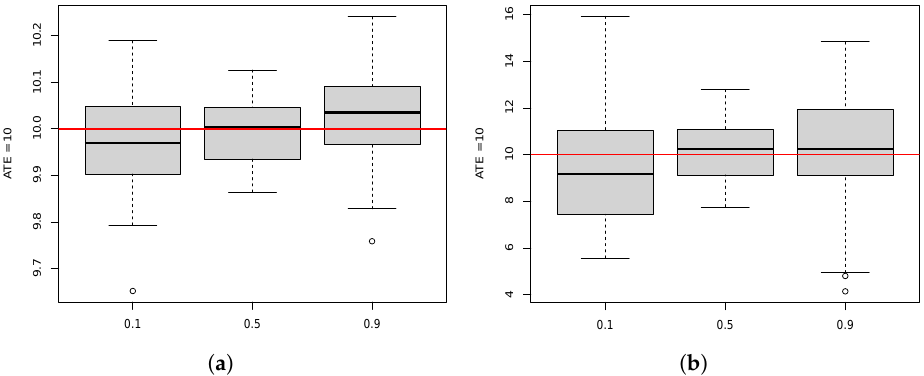
Figure 7. ATE true = 10 estimations for different participation rates for Regression method. Note that the scales of the two figures are not the same. ( a ) Reg linear. ( b ) Reg non-linear.